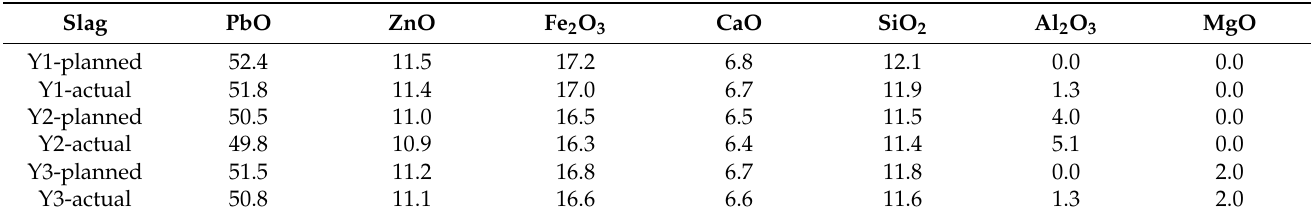
Table 2. The target and actual compositions of lead-rich slags for reduction